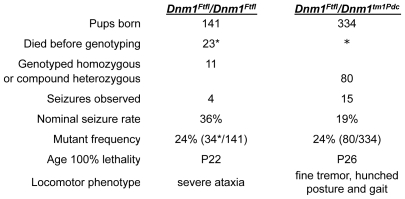
Fitful and compound heterozygous Dnm1 seizure and locomotor phenotypes.Shown is the frequency of fitful homozygous (Dnm1Ftfl/Dnm1Ftfl) and compound heterozygous (Dnm1Ftfl/Dnm1tm1Pdc) mutant mice and their respective seizure incidence and locomotor phenotypes. The fitful homozygotes shown were from fully informative matings from the mapping cross used to map the recessive phenotype; the compound heterozygotes were from crosses between single heterozygotes from respective FVB-fitful and B6-null colonies. The asterisk is used to indicate that the latter population was observed almost daily from P12 through demise (P16–P23), whereas the former were observed at weaning age only – suggesting that death occurred in these mutants between P12 and P21.